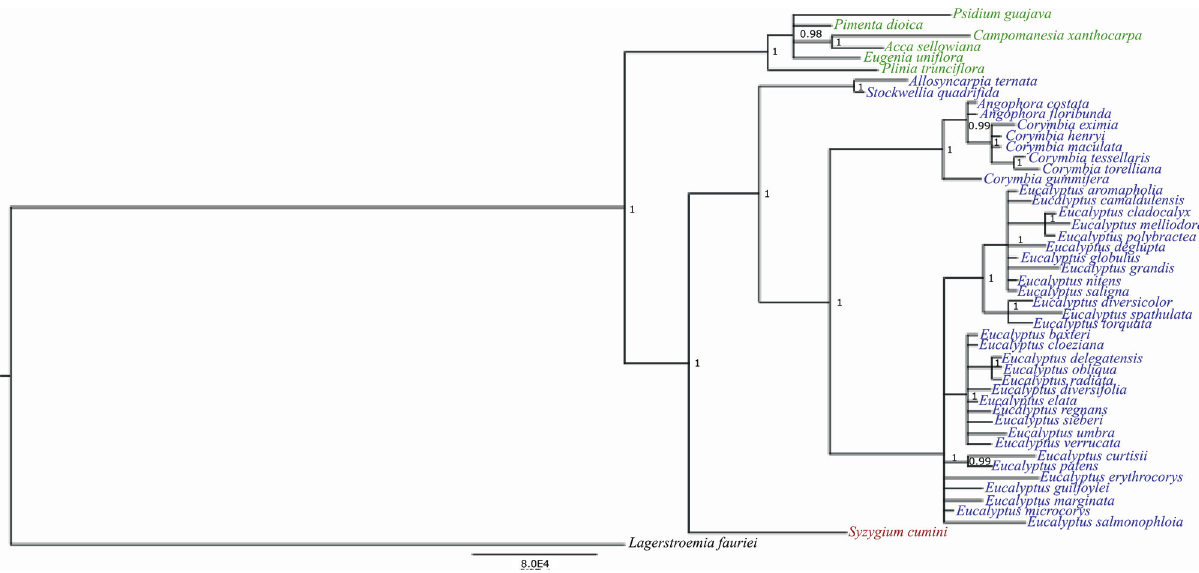
Figure 4 - Bayesian phylogeny based on the cp ycf2 sequence of 48 Myrtaceae species and the outgroup species Lagerstroemia fauriei (Myrtales: Lythraceae; KT358807). Branch length is proportional to the inferred divergence level. The scale bar indicates the number of inferred nucleic acid substi- tutions per